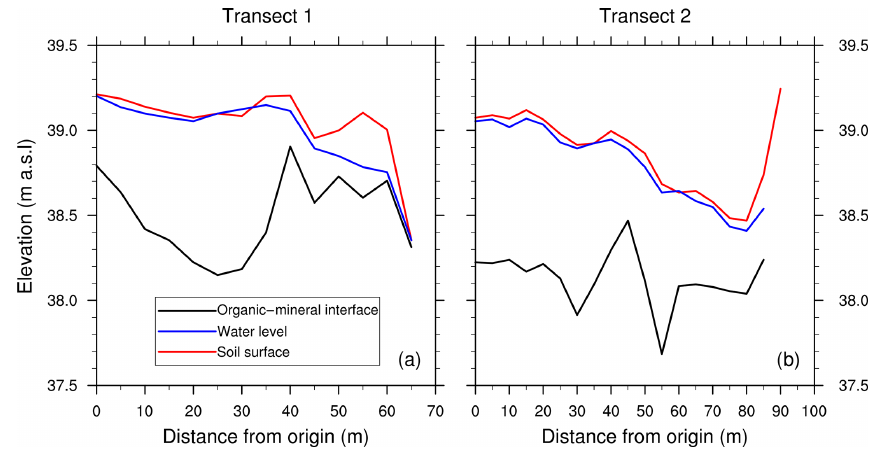
Figure 3. Topographical measurements of soil surface (red) and manual measurements of water level (blue) and organic–mineral interface (black) along both transects. Manual measurements of water level were made on 27 July